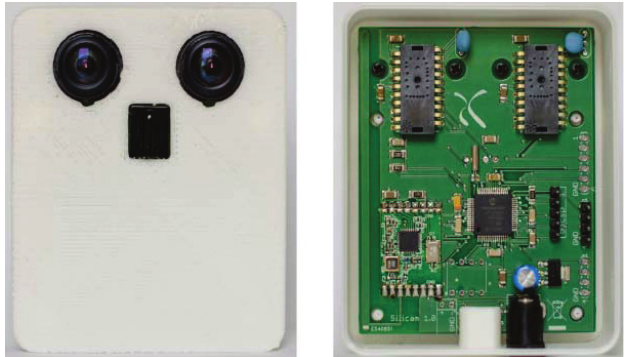
A low resolution visual sensor containing two mouse sensors controlled by a digital signal controller. Each mouse sensor captures an image with a resolution of 30 × 30